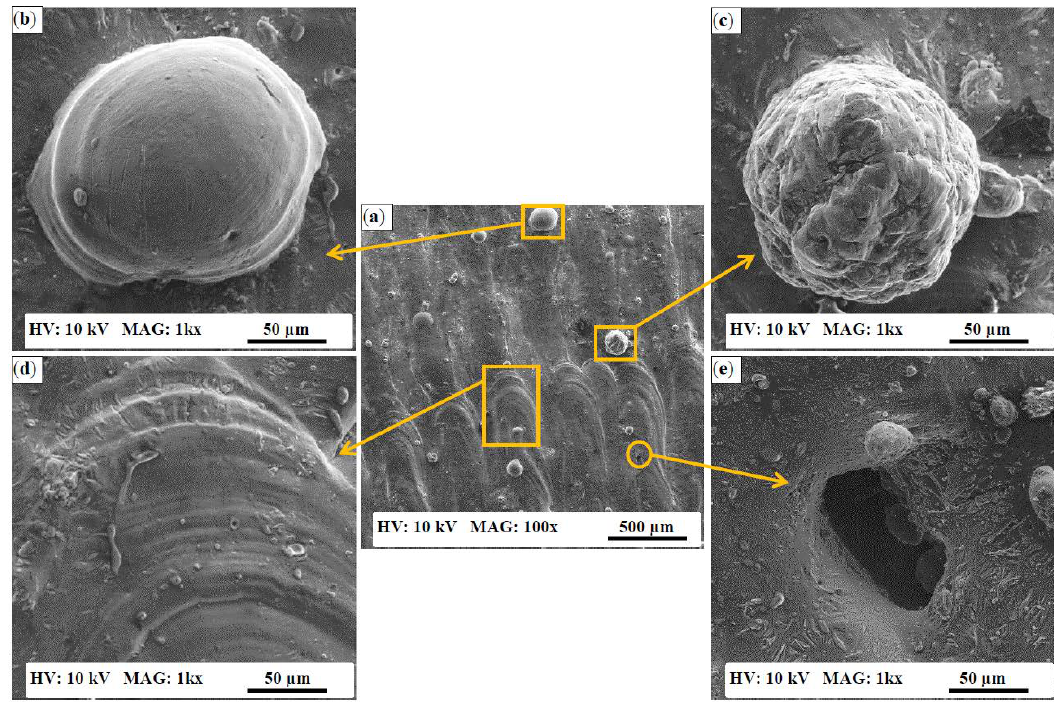
Figure 3. ( a ) SEM observations of the as-built AlSi10Mg surface defects, ( b ) partially melted powder particle, ( c ) ellipsoidal balling, ( d ) track of the strip laser scan, and ( e ) pore formed on the surface.